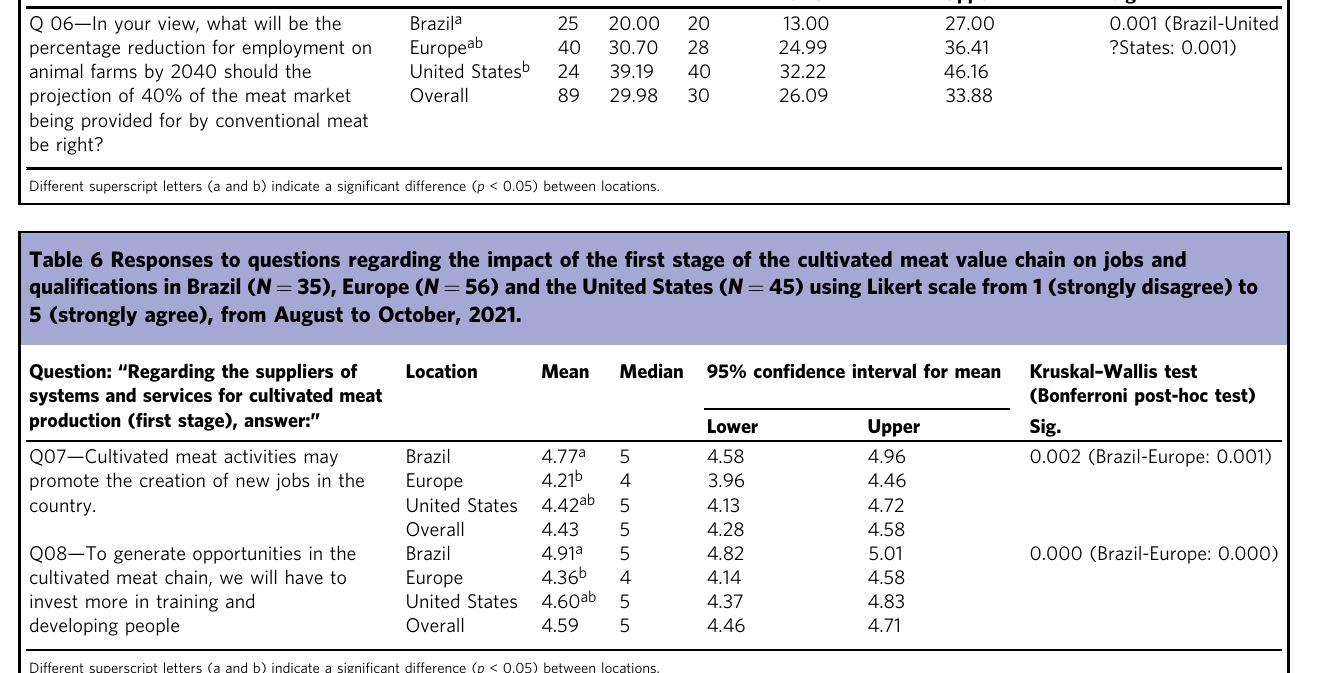
Q 06 — In your view, what will be the percentage reduction for employment on animal farms by 2040 should the projection of 40% of the meat market being provided for by conventional meat be right?